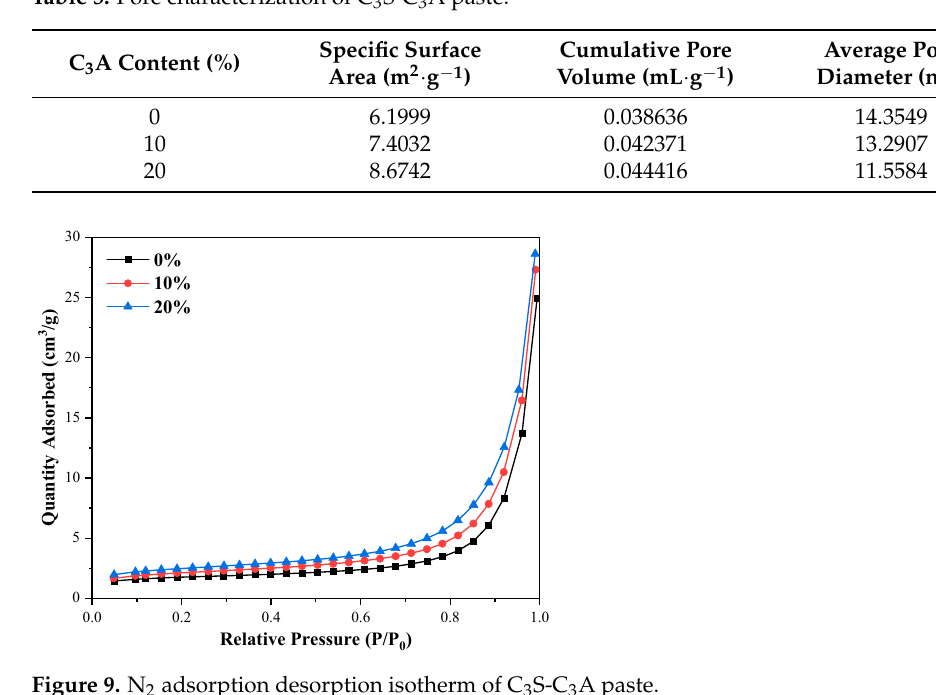
Figure 10. Pore diameter distribution of C 3 S-C 3 A paste.